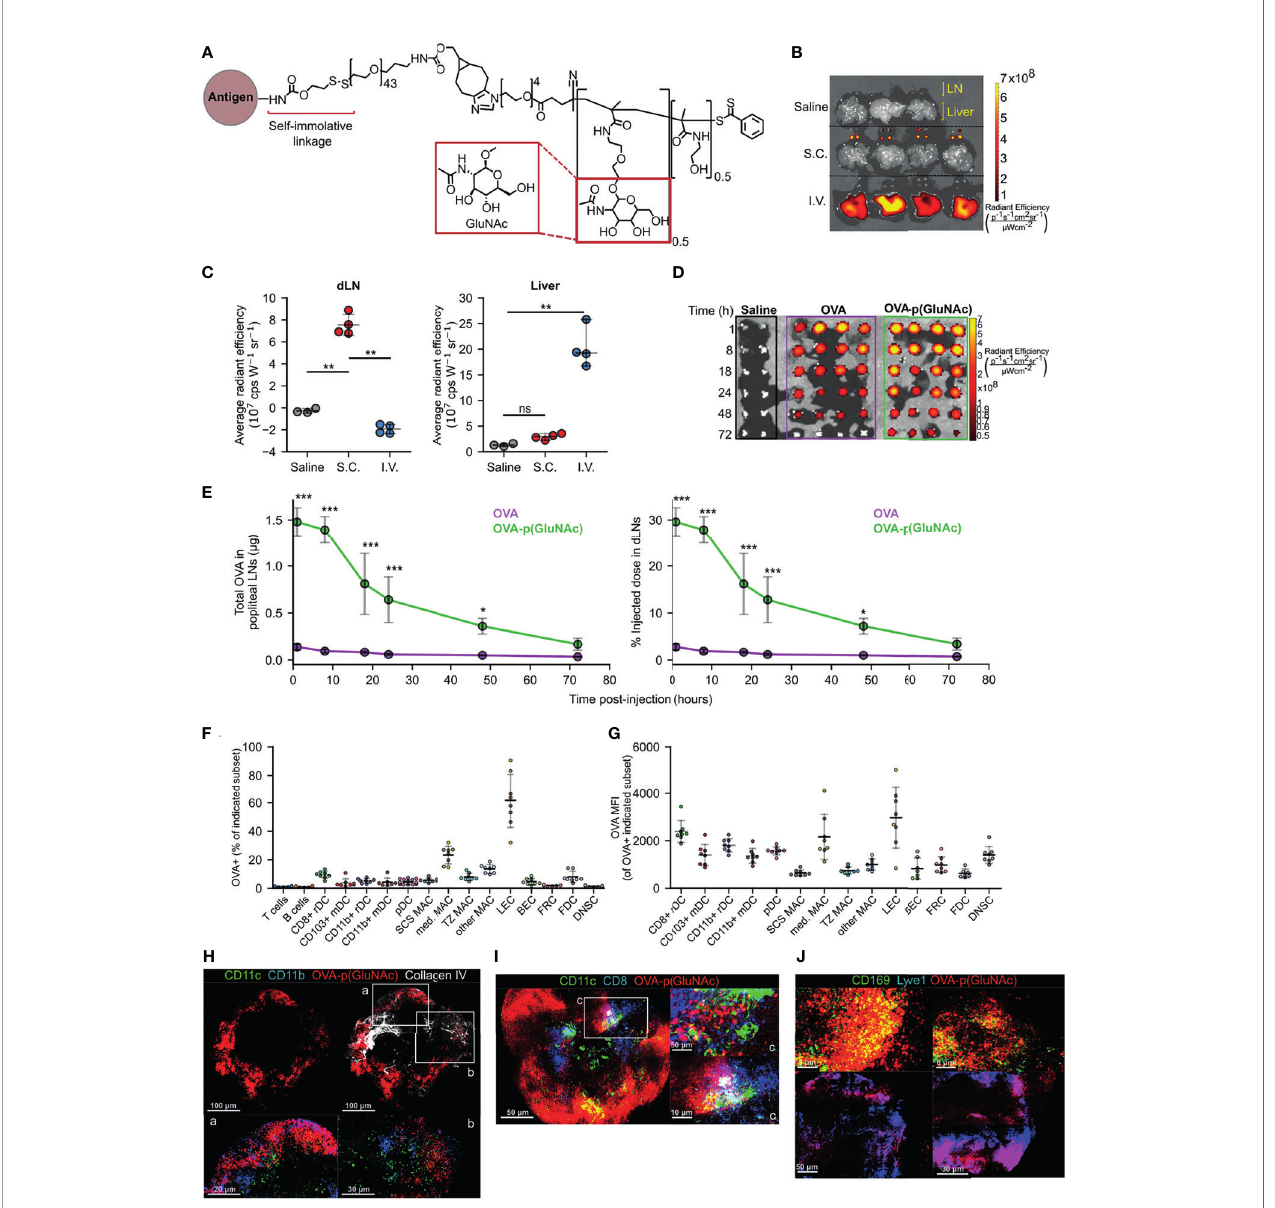
FIGURE 1 | (A) Structure of p(GluNAc) conjugated to an antigen lysyl side chain amine via a self-immolative linker. (B, C) Accumulation of OVA 647 or OVA 647 -p (GluNAc) in the dLNs and livers 15 h after s.c. or i.v. injection. (B) Representative NIR images of dLNs and liver. (C) Average NIR intensities of dLNs and livers. (D, E) Mice were injected with saline or 5 m g of OVA 647 or OVA 647 -p(GluNAc) s.c. and the draining popliteal LNs were isolated and imaged at various timepoints between 1-72 h post-injection n (dLN)= 2 for saline and 4 for OVA 647 or OVA 647 -p(GluNAc) at each timepoint. (D) Representative NIR images of dLNs. (E) Quanti fi cation of OVA accumulation in dLNs, expressed as m g (left) or % of initial injected dose (right). (F, G) Flow cytometry analysis of LN cells that took up OVA 647 -p(GluNAc) 15 h after s.c. injection of 20 m g of OVA 647 -p(GluNAc). DC, dendritic cell; pDC, plasmacytoid dendritic cell; MAC, macrophage; SCS, subcapsular sinus; med, medullary; TZ MAC, T cell zone macrophage; LEC, lymphatic endothelial cell (CD45 - CD31 + gp38 + ); BEC, blood endothelial cell (CD45 - CD31 + gp38 - ); FRC, fi broblastic reticular cell (CD45 - CD31 - gp38 + CD21/35 - ); FDC, follicular dendritic cell (CD45 - CD31 - gp38 + CD21/35 + ); DNSC, double negative stromal cell (CD45 - CD31 - gp38 - ). (F) Percent of each cell subset that is OVA + . (G) OVA 647 MFI of each OVA + cell subset. (H – J) Representative whole mount confocal images of immunostained dLNs after s.c. injection of OVA 647 -p(GluNAc) (red). (H) LNs stained versus CD11c (green), CD11b (blue) and Collagen IV (white), 8 h post-injection (p.i.). CD11c + CD11b + DCs are shown in aqua and co-localized OVA-p(GluNAc) is shown in magenta. Scale bar ranges from 20-100 m m and is indicated in each panel. (I) LNs stained versus CD11c (green) and CD8 (blue) 18 h p.i. CD11c + CD8 + double positive DCs are shown in aqua and co-localized OVA-p(GluNAc) is shown in magenta. Scale bar ranges from 5-50 m m and is indicated in each panel. (J) LNs stained versus CD169 (green, top) and Lyve1 (blue, bottom). Co-localized OVA-p(GluNAc) with CD169 + macrophages is shown in yellow (top), and OVA-p(GluNAc) co-localized with the lymphatics is shown in magenta (bottom). Scale bar ranges from 5-50 m m and is indicated in each panel. Data represent mean ± SD. *p ≤ 0.05, **p ≤ 0.01, ***p ≤ 0.001, ns is not signi fi cant by one-way ANOVA using Tukey ’ s post hoc test in (C) , and two-way ANOVA using Sidak ’ s post hoc test in (E)